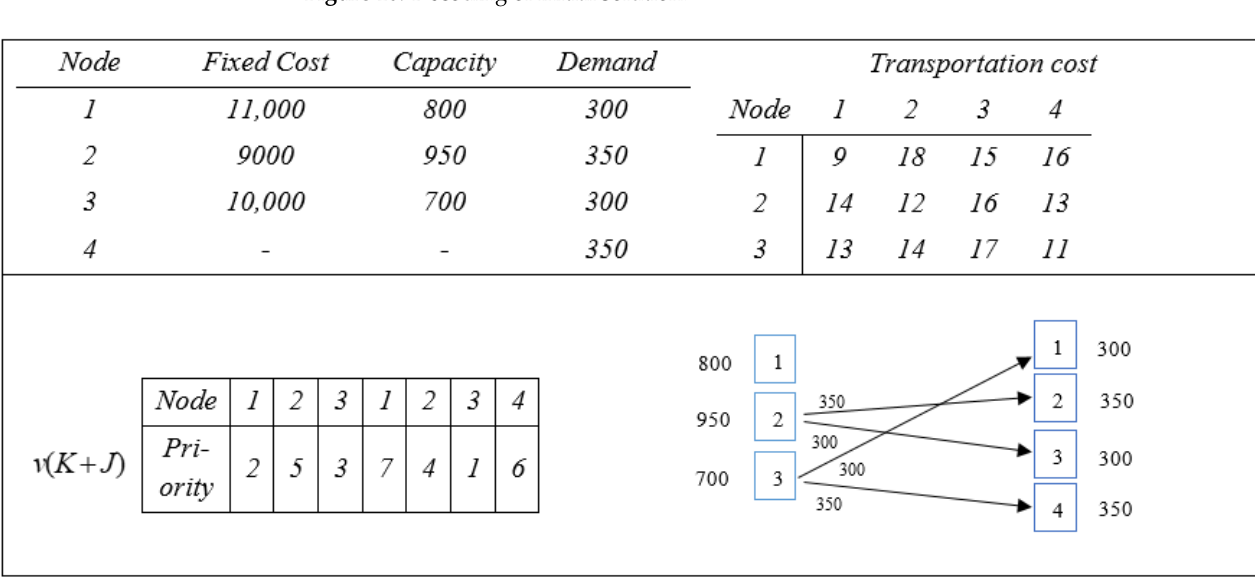
Figure 11. Initial solution and decoding of problem in stage 2.